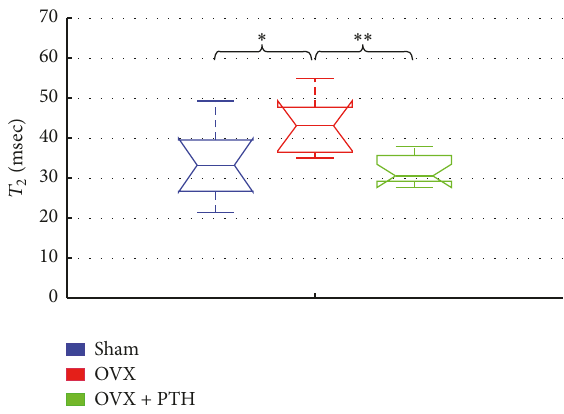
Figure 7: Prevention experiment – 𝑇 2 measurements 6-weeks postoperation, measured at peripheral zone of metaphysis of femurs bones. Significant increase of 𝑇 2 for the femurs of OVX bones compared to the Sham operated control group at peripheral zone of metaphysis (by Kruskal-Wallis test followed by Bonferroni multiple- comparison test ∗ 𝑃 < 0.008 ).